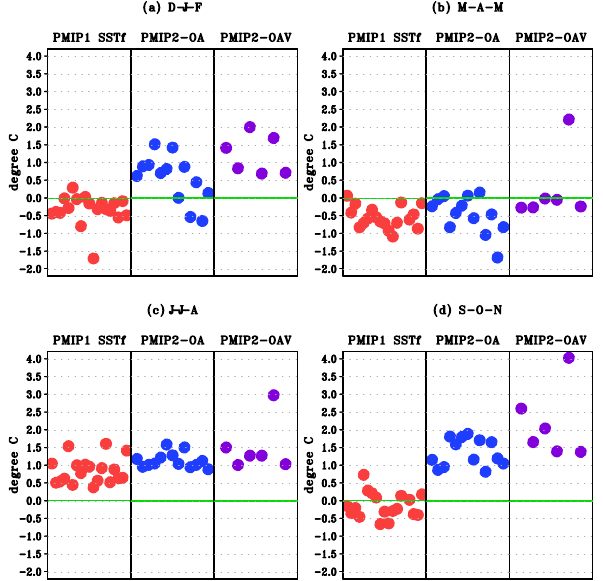
Fig. 3. Seasonal change in surface air temperature ( ◦ C) averaged over northern high latitudes (60 ◦ N–90 ◦ N) for the PMIP simula- tions. (a) DJF mean, (b) MAM mean, (c) JJA mean and (d) SON mean. The red circles are for PMIP1, the blue ones for PMIP2-OA and the purple ones for PMIP2-OAV. Note that the changes are com- puted with respect to the control simulation of the respective model, that is, 6ka minus